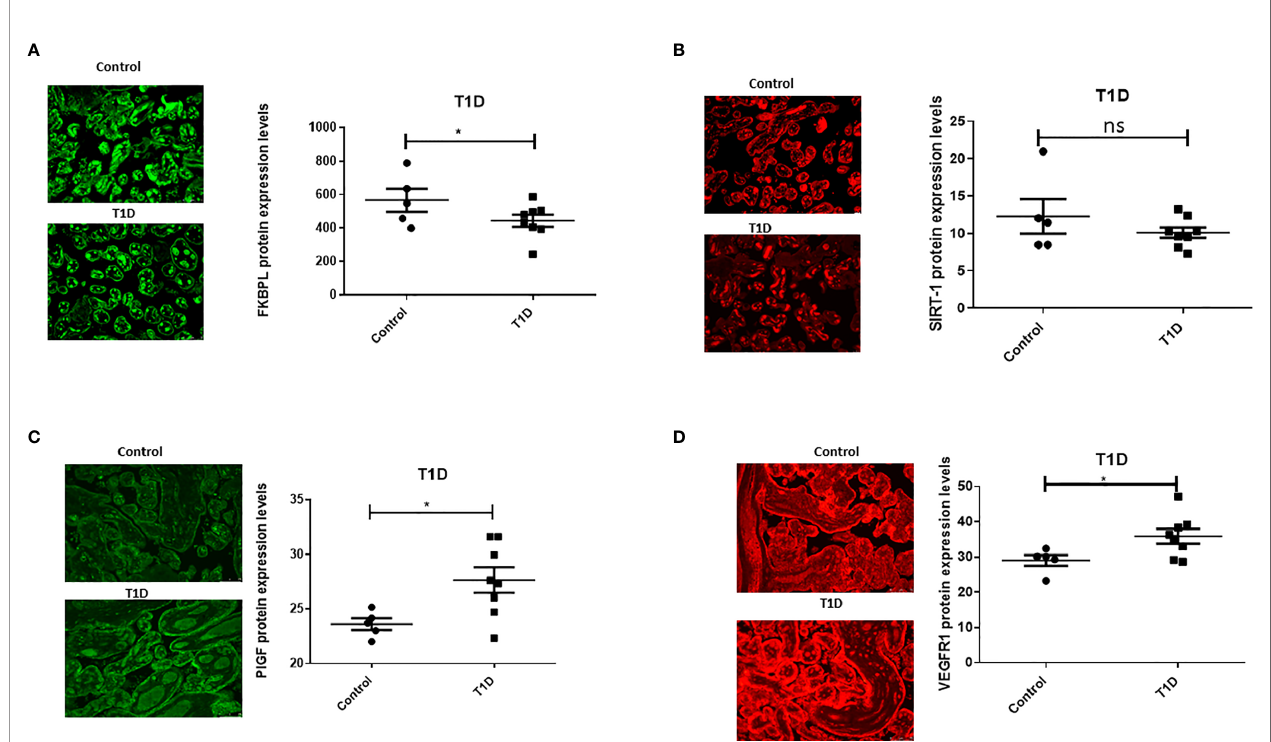
TABLE 2 | Adjusted correlations for differences in gestational age between diabetic and healthy placentae. Samples FKBPL SIRT-1 PIGF VEGF-R1 Pearson Correlation Pearson Correlation Pearson Correlation Pearson Correlation correlation controlled by GA correlation controlled by GA correlation controlled by GA correlation controlled by GA T1D r=-0.581 r=-0.65 r=-0.428 r=-0.578 r=0.7 r=0.611 r=0.643 p=0.037 p=0.022 p=0.145 p=0.049 p=0.008 p=0.035 p=0.051 p=0.024 GDM r=-0.059 r=-0.657 r=-0.964 r=-0.92 r=0.358 r=0.137 r=0.584 r=0.825 p=0.88 p=0.077 p=0.000 p=0.001 p=0.345 p=0.746 p=0.098 p=0.012 Bold indicates statistical signi fi